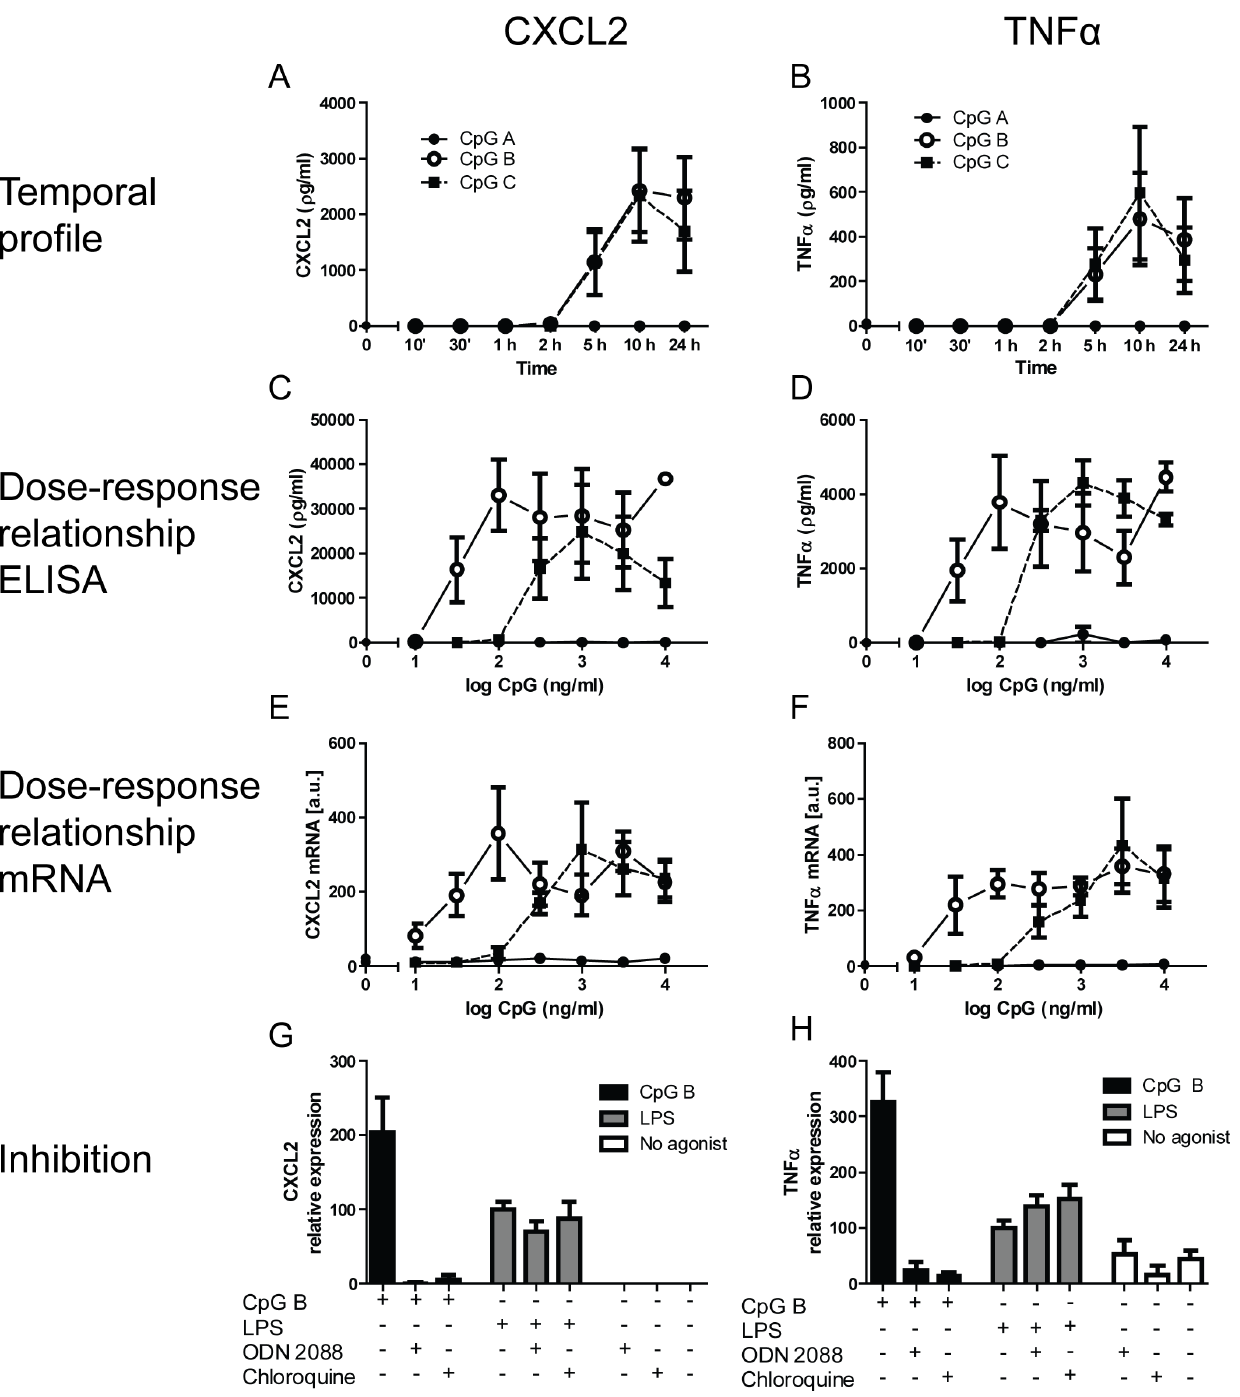
Figure 1. TLR9-stimulated responses in cardiac fibroblasts. Temporal profiles (10 min, 30 min, 1 h, 2 h, 5 h, 10 h and 24 h) of (all at 100 ng/ml) CpG A (dots), CpG B (open circles) or CpG C (squares)-stimulated release of CXCL2 (panel A) and TNF a (panel B) in murine cardiac fibroblasts (CF). Each data point represents the mean 6 SEM of 3 separate experiments. Dose-response relationships of CpG A (dots), CpG B (open circles) and CpG C (squares) –stimulated release of CXCL2 (panel C) and TNF a (panel D) at 18 hours. Each data point represents the mean 6 SEM of 6 experiments. Expression levels of CXCL2 (panel E) and TNF a (panel F) were analyzed by qPCR. Each data point represents the mean 6 SEM of 4 experiments. TLR9 specificity studies were performed on murine CFs exposed to CpG B (100 ng/ml) or LPS (10 ng/ml) with or without the presence of ODN 2088 (10 m g/ml) or chloroquine diphosphate (5 m g/ml). Levels of CXCL2 (panel G) and TNF a (panel H) were analyzed after 18 hours. Each data point represents the mean 6 SEM of 3 experiments.